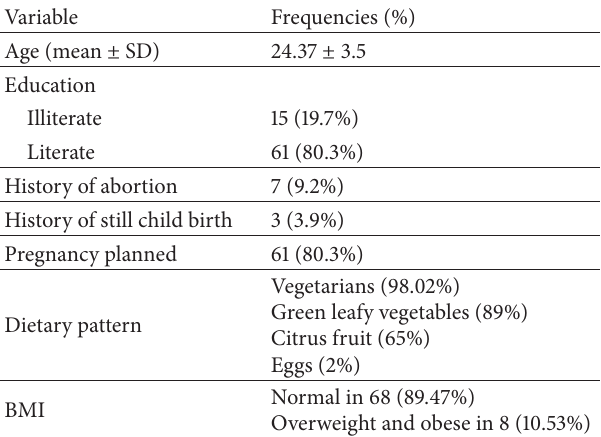
Table 1: The descriptive data of pregnant women participating in the study ( 𝑁 = 76 ).